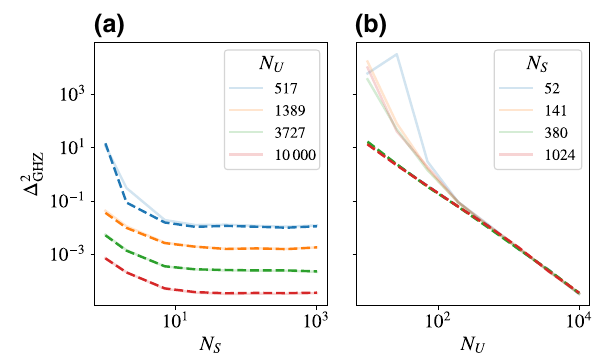
FIG. 7. Using the biased estimator for purity in Eq. (E6) on the data from Fig. 5 reduces the errors for smaller values of N U . The dashed lines show the errors calculated using the biased estimator; the solid lines are the original data from Fig. 5.